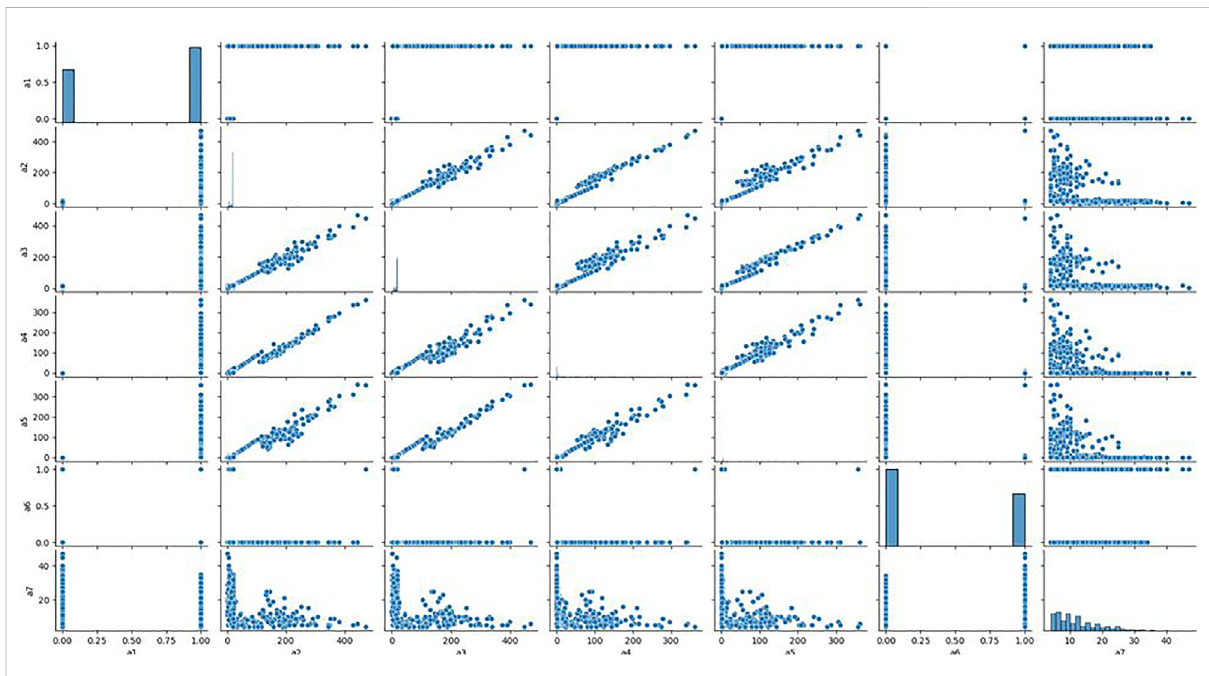
FIGURE 3 Relationshipbetweenthemostrelevantfeatures.Weanalyzedthecorrelationbetweenthesevenfeaturesmostrelatedtothecloneproportion in the cross clone proportion correlation analysis, and found that there was no consistent correlation between the seven features from a two- dimensional perspective.